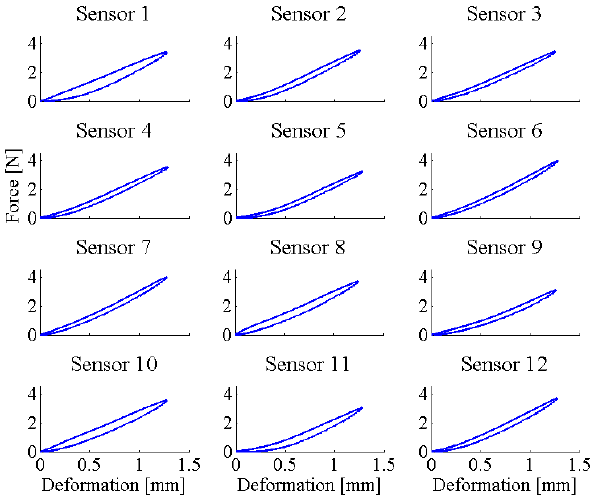
Figure 8. Deformation-to-force loading-unloading curves: the fitted curves are reported for each sensor.